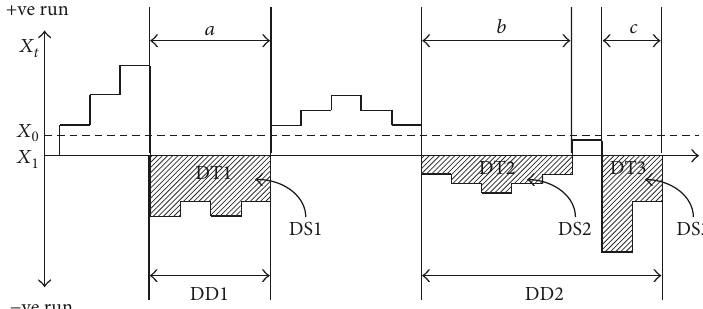
Figure 7: Drought characteristics using the run theory for a given threshold level.